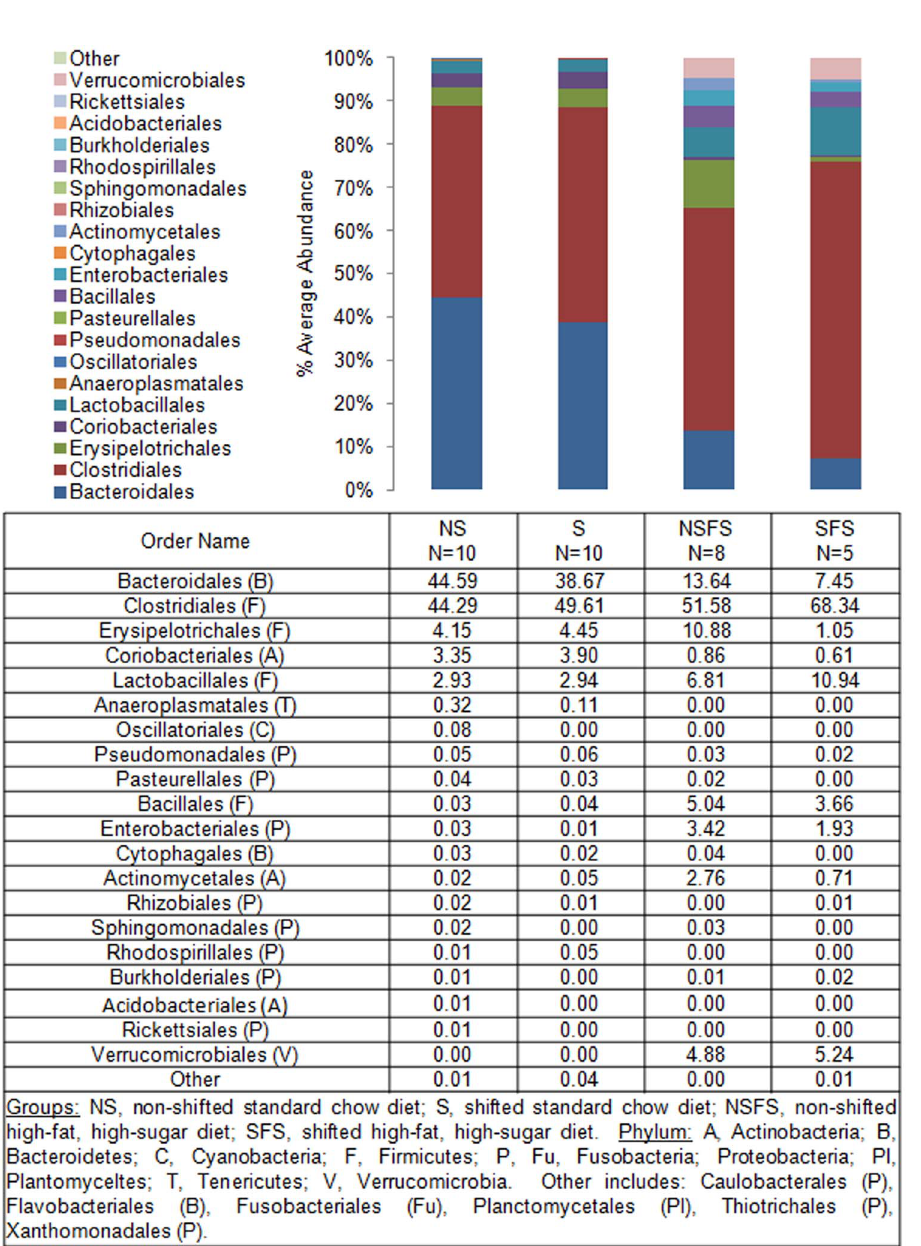
Figure 5. Mouse gut microbial community structure at the order level. The bar graph graphically represents the average relative abundance of classified bacteria SSU rRNA gene amplicons belonging to the most abundant taxon at the order